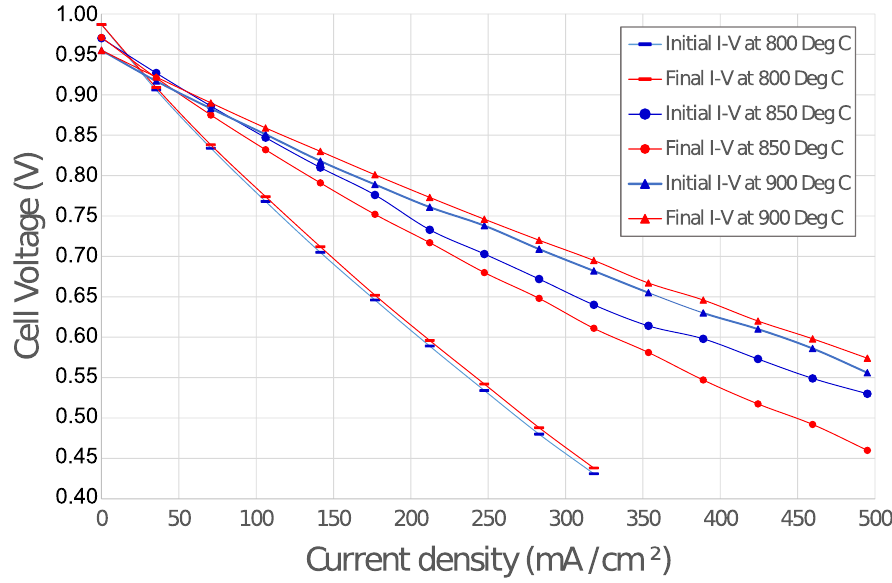
Figure 16. Voltage-current density comparison of the cell at different temperatures before and after the testing program—At 800 ◦ C, 850 ◦ C and at 900 ◦